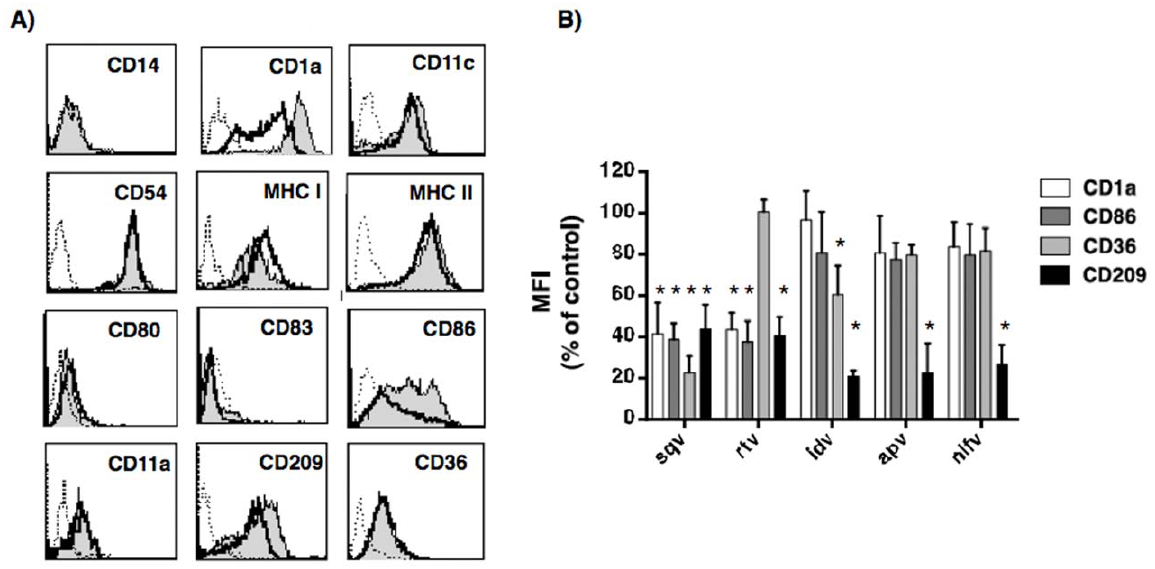
Figure 1. Phenotype of immature DCs generated in the presence of HIV-1 protease inhibitors. Purified CD14 + monocytes where cultured with regular medium containing GM-CSF (50 ng/ml) and IL-4 (1000 U/ml), with or without 20 m M of the indicated protease inhibitor. After 7 days, cells were collected, stained with the reported antibodies, and analyzed by flow cytometry. (A) Representative example for histogram profiles of iDCs generated in the presence (gray histograms) or in the absence (open histograms) of rtv. Open dot histograms represent isotype matched immunoglobulin staining. (B) Bars graph reports mean and standard deviation of the Mean Fluorescence Unit (MFU). Results are reported as the percentage of the MFU expressed on iDCs generated in regular medium, and are representative of ten independent experiments. (* p , 0.005).